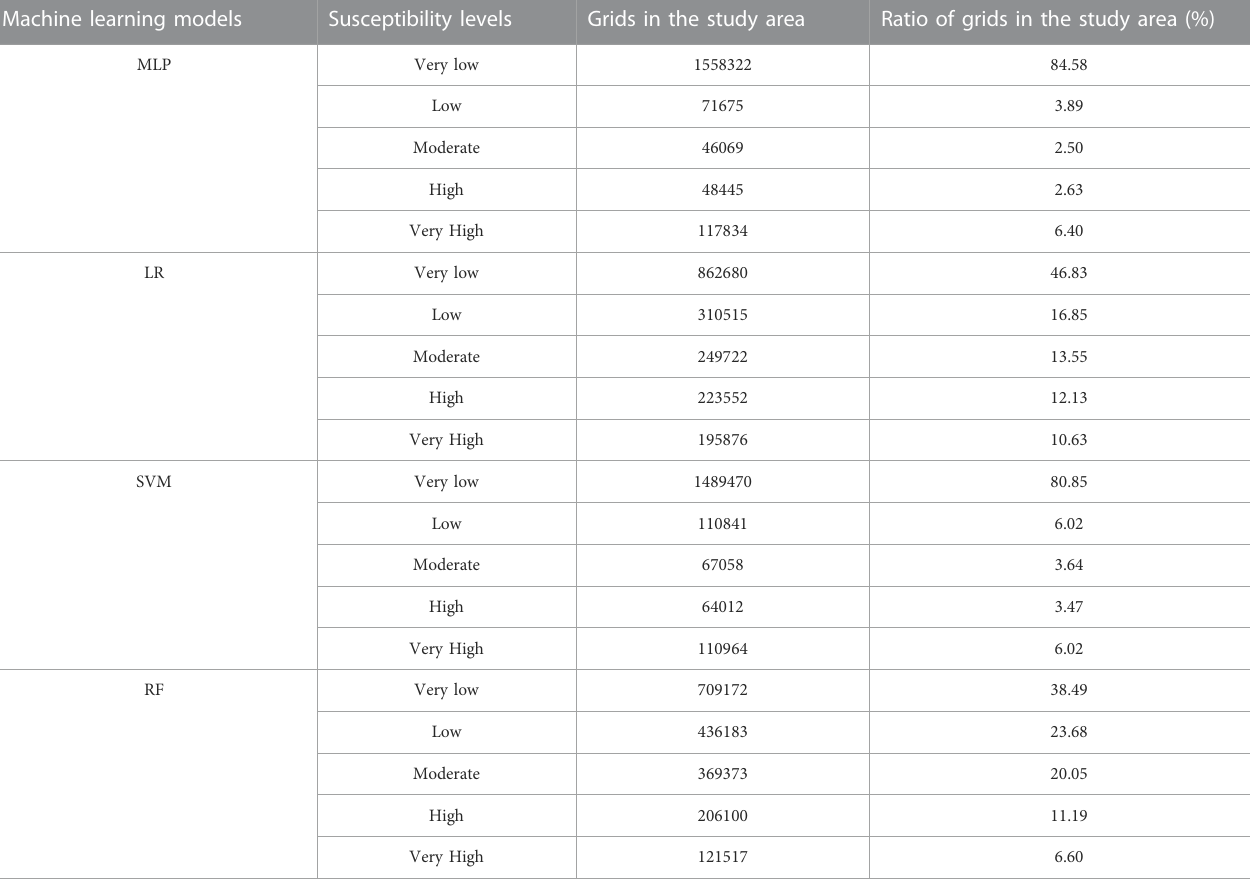
TABLE 3 Classi fi cation results of fl ash fl ood susceptibility index. Machine learning models